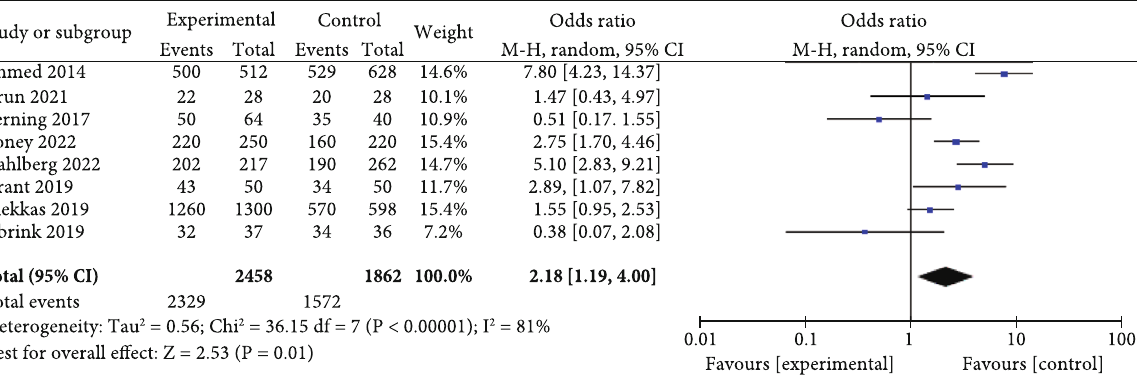
Figure 6: E ffi cacy of high-quality nursing on nursing satisfaction. With heterogenity 0.56, Chi 2 = 36 : 15 , df = 7 , I 2 = 81 % .